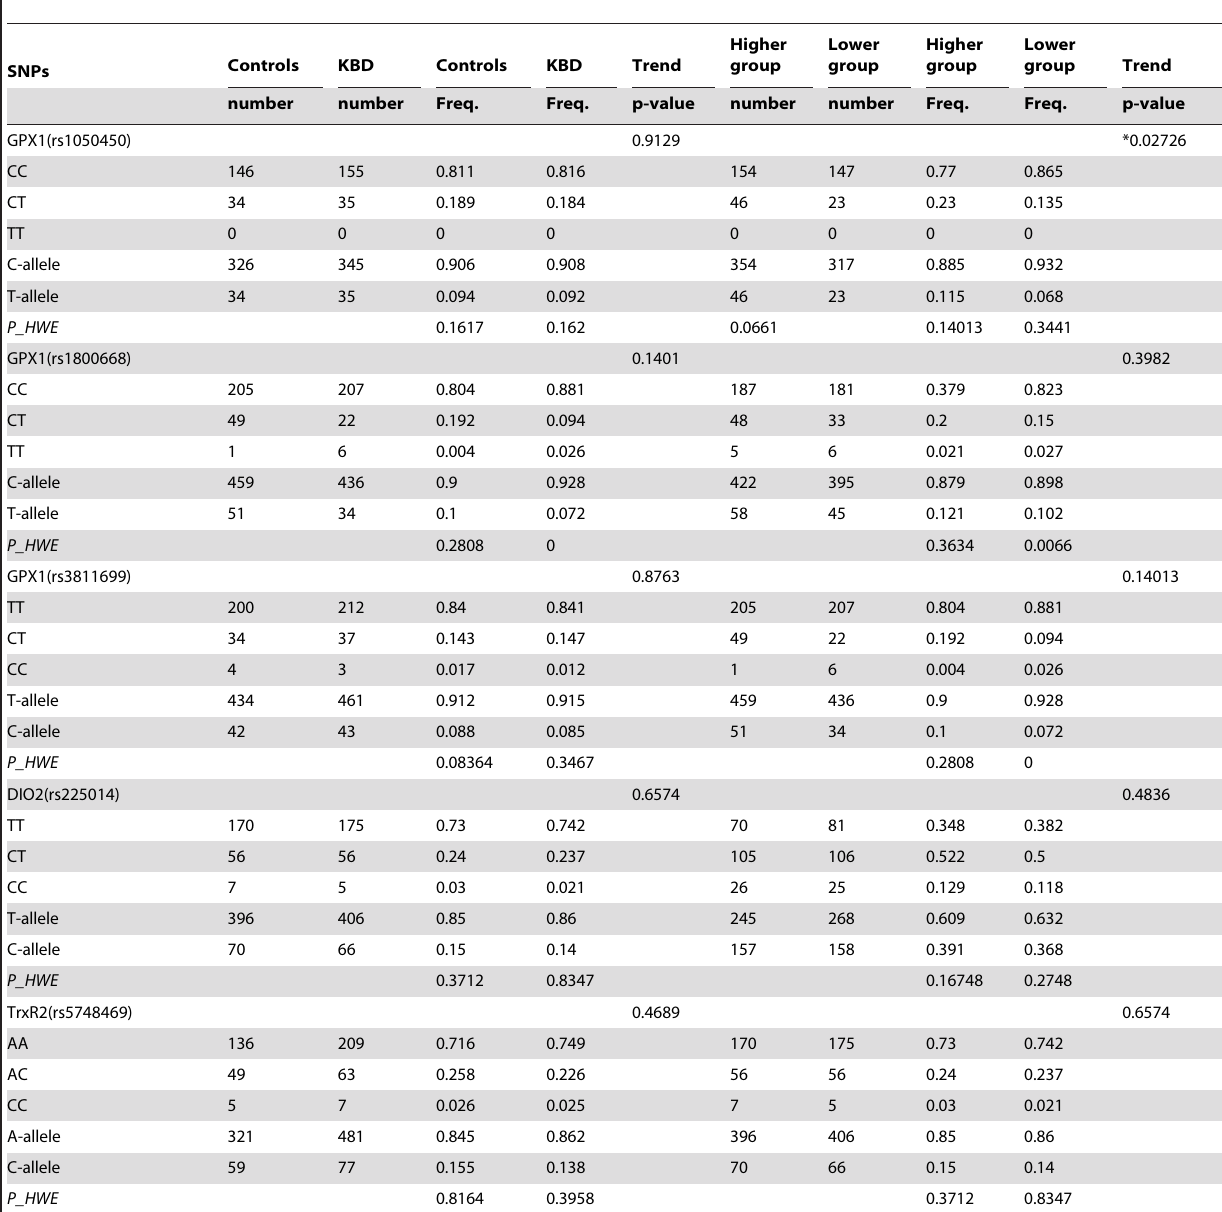
Table 5. Genotype and allele frequencies of polymorphisms across selenoprotein genes by serum iodine concentration in Tibetan